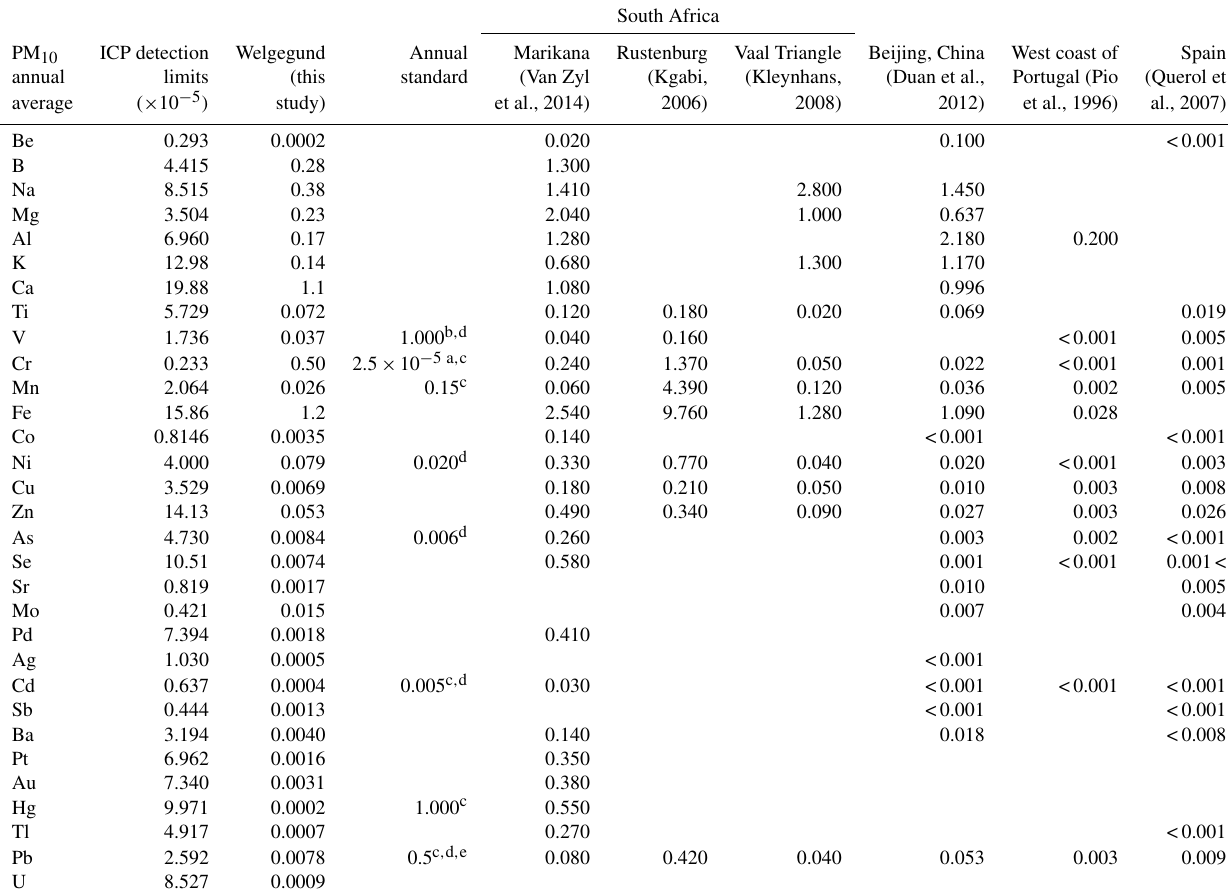
Table 1. Annual mean PM 10 trace metal concentrations measured at Welgegund; annual average standards; and annual average trace metal levels determined in other studies in South Africa, China and Europe. Concentration values are presented in µgm − 3 . Italic typeface indicates concentrations of species that were below the detection limit of the analytical technique for the entire sampling period in all three size